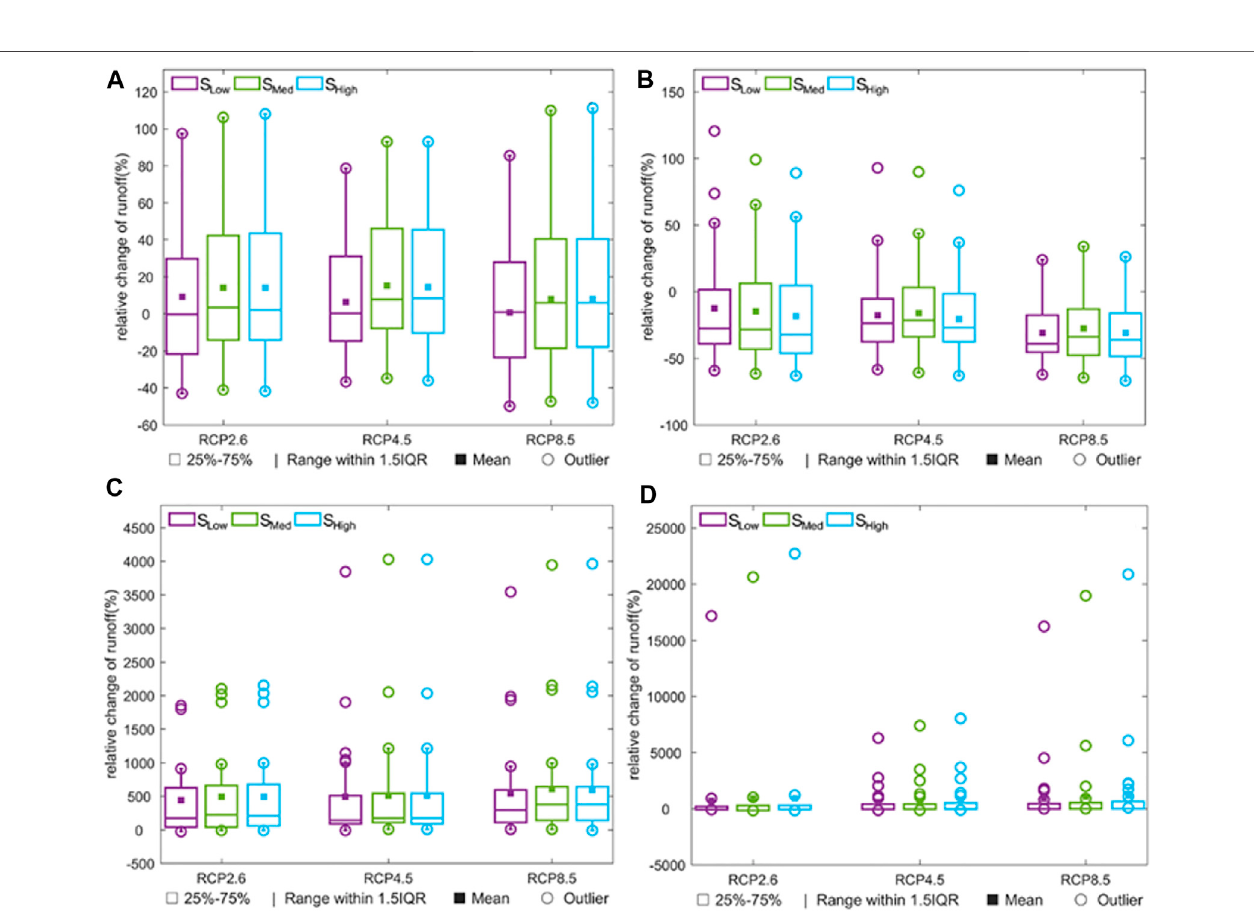
FIGURE 5 | Box diagram of the relative changes of annual average/seasonal runoff of different layout schemes in 2021 – 2050 in the Huangshui River Basin under futureclimatescenarios: (A) representsannualpattern, (B) represents thepattern inwet season, (C) represents thepattern innormal season, (D) represents thepattern in dry season. The small rectangles in purple, green and blue represent the 25% to 75% quantiles of relative changes of annual(seasonal) average runoff. I (range within 1.5IQR) represents one and a half times the quartile distance. The black solid box represents the mean value. Open squares indicate outliers.